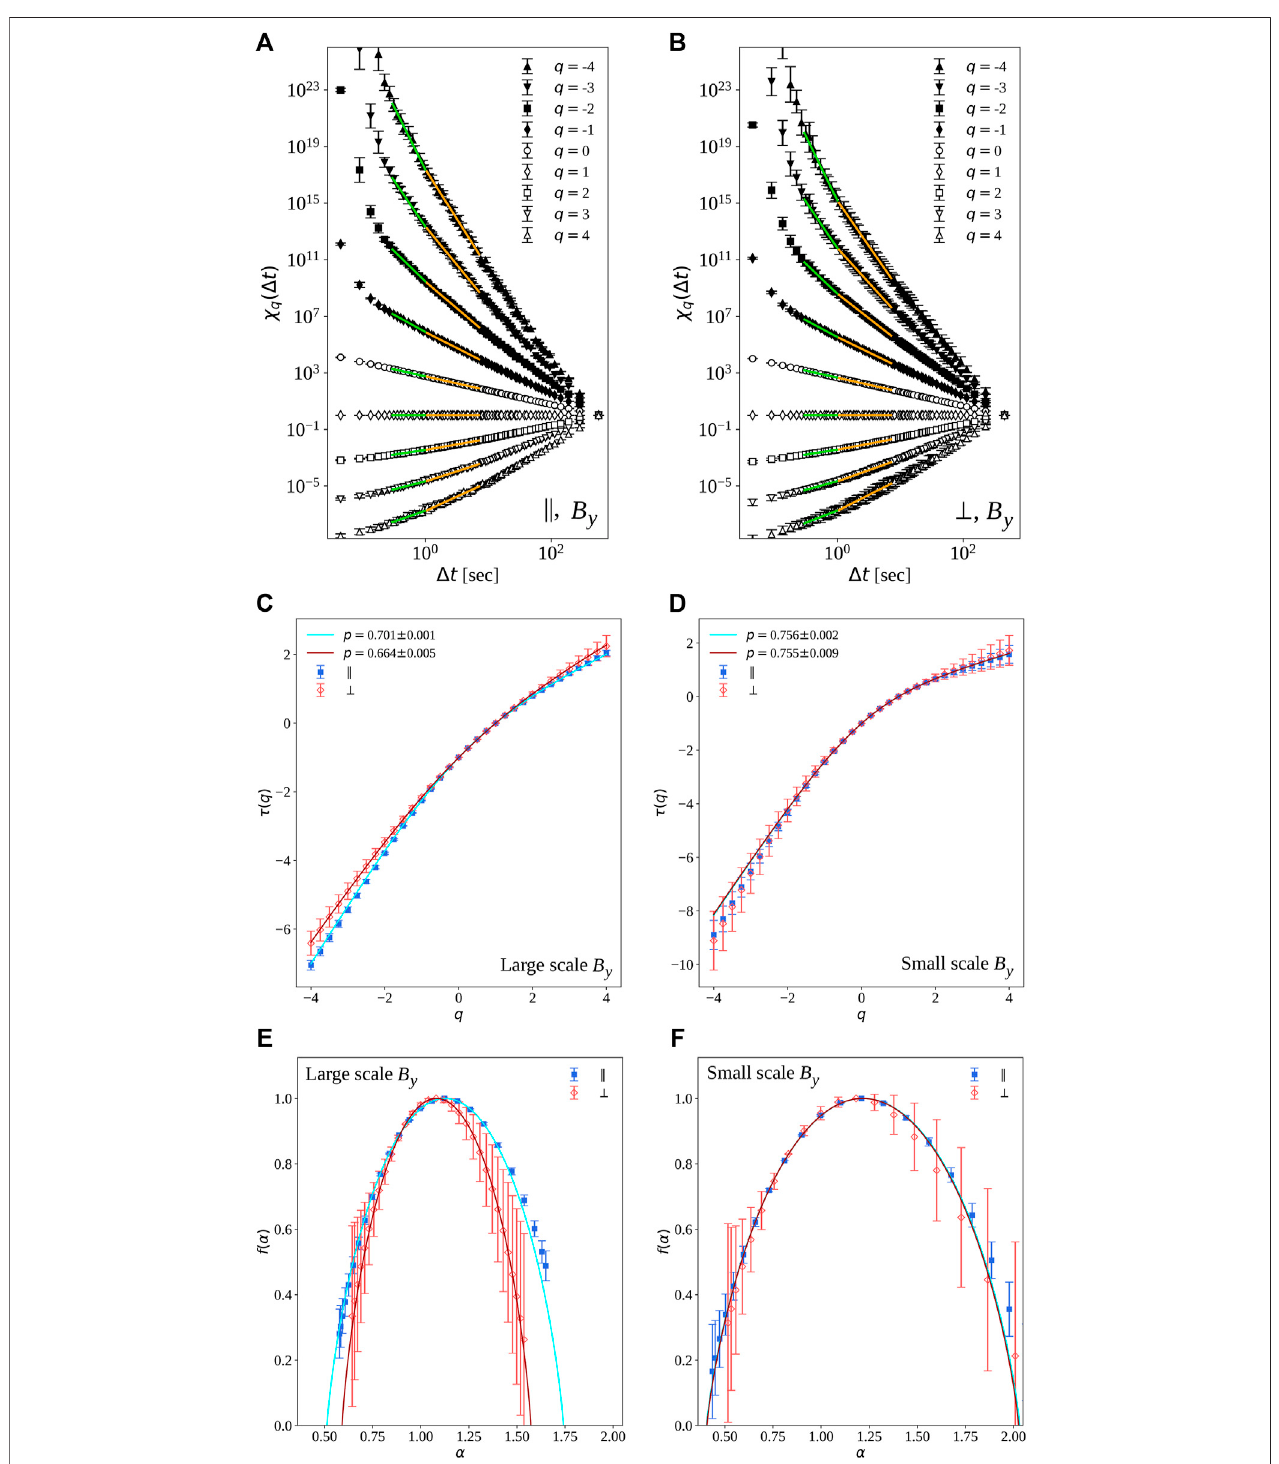
FIGURE 4 | Example of multifractal analysis for the B y component measured by Cluster 2. (A,B) : partition function χ q ( Δ t ) in the quasi-parallel (A) and quasi- perpendicular (B) samples, for q indicated in the legend. Error bars are the standard deviation of the measure over the partition boxes (the argument of left-hand side of Eq. 2 ). Power-law fi ts are indicated in the larger-scale (yellow lines) and smaller-scale (green lines) ranges, with a break around Δ t ≃ 1 s, noticeable for higher orders q . (C,D) : scaling exponents τ q versus the order q , in the larger (C) and smaller (D) ranges of scales, for quasi-parallel ( (cid:3) ) and quasi-perpendicular ( ⊥ ) intervals. Error bars are obtained through the power-law fi t, and are slightly larger for the quasi-perpendicular interval. (E,F) : the corresponding multifractal spectra f ( α ). Error bars are considerably ampli fi ed by the Legendre transformation. In (C – F) , full lines represent the p-model ( 3 ) obtained fi tting the scaling exponents τ q .